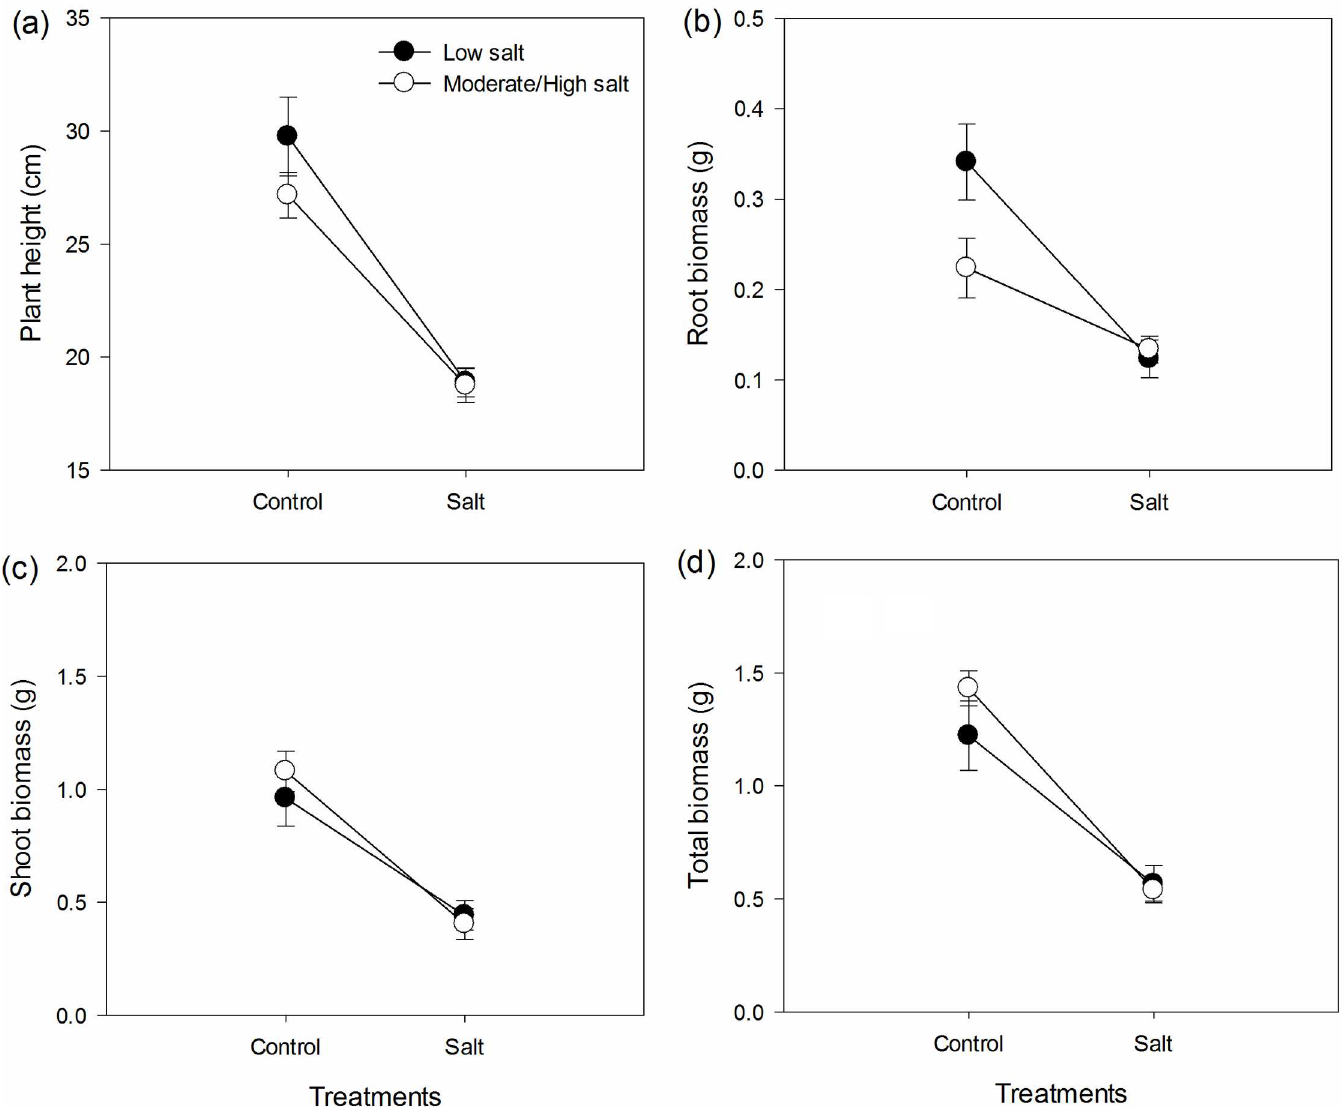
Fig 3. Effect of salt treatment on the plant height (a) and root (b), shoot (c) and total biomass (d) of S . canadensis populationsfrom moderate/severe salt- level soil and low salt-level soil. Values are shown in mean ± standard error (SE).